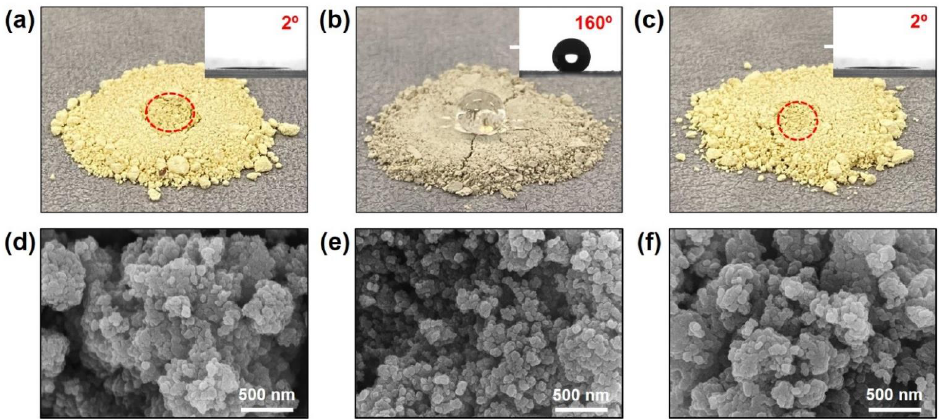
Figure 2. Microscope images of V 2 O 5 -WO 3 /TiO 2 ( a ), silanized V 2 O 5 -WO 3 /TiO 2 ( b ), and heat-treated V 2 O 5 -WO 3 /TiO 2 ( c ) (insets are contact angle measurement). The red circle marks the location where the water is absorbed on the catalyst. SEM images of V 2 O 5 -WO 3 /TiO 2 ( d ), silanized V 2 O 5 -WO 3 /TiO 2 ( e ), and heat-treated V 2 O 5 -WO 3 /TiO 2 ( f ). Table 1. X-ray fluorescence analysis and Brunauer-Emmet-Teller (BET) results of the V 2 O 5 - WO 3 /TiO 2 , silanized V 2 O 5 -WO 3 /TiO 2 , and heat-treated V 2 O 5 -WO 3 /TiO 2 catalyst. Chemical Composition (wt.%) Sample